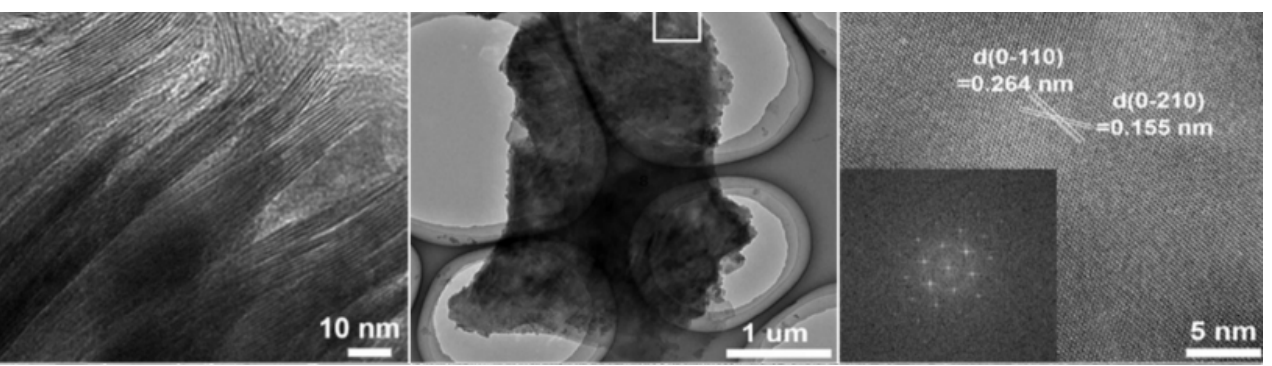
Figure 6. Specific region h-Ti 3 C 2 nanoflakes in HR-TEM micrograph. Reproduced with permission from [65]. Copyright 2019 Wiley.